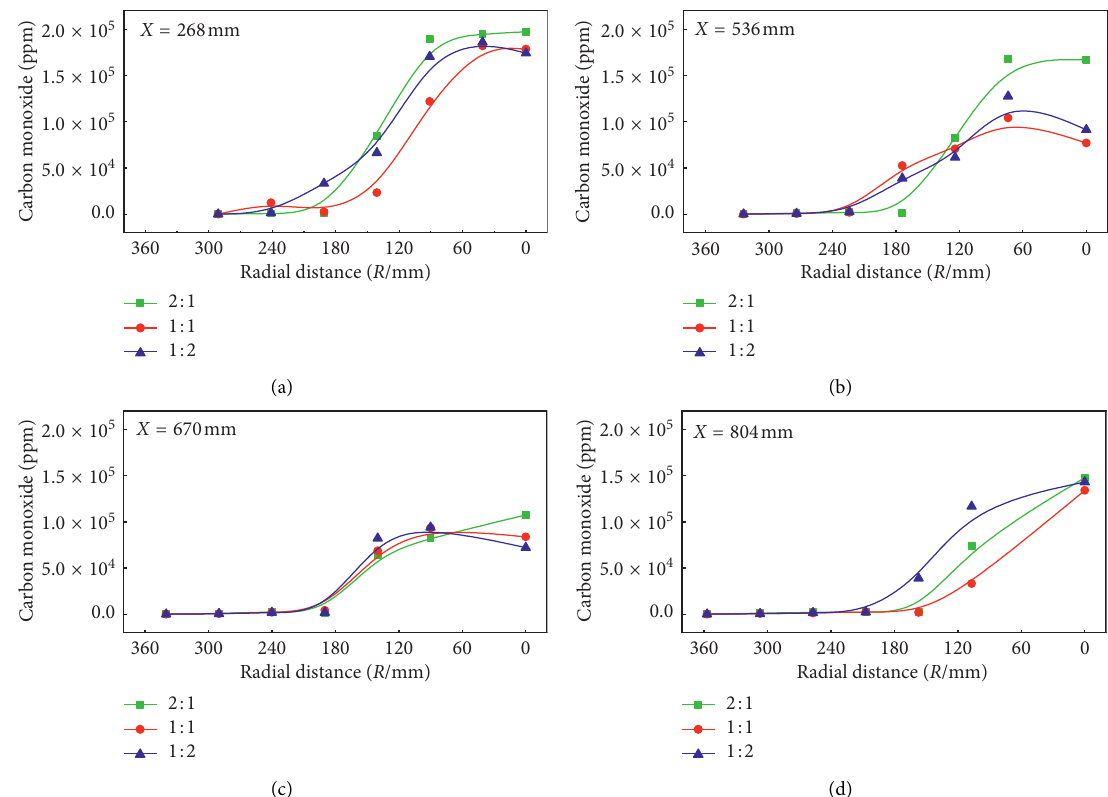
Figure 6: CO concentration profiles along radial distance for different ISA/OSA. (a) X � 268mm. (b) X � 536mm. (c) X � 670mm. (d) X � 804mm.